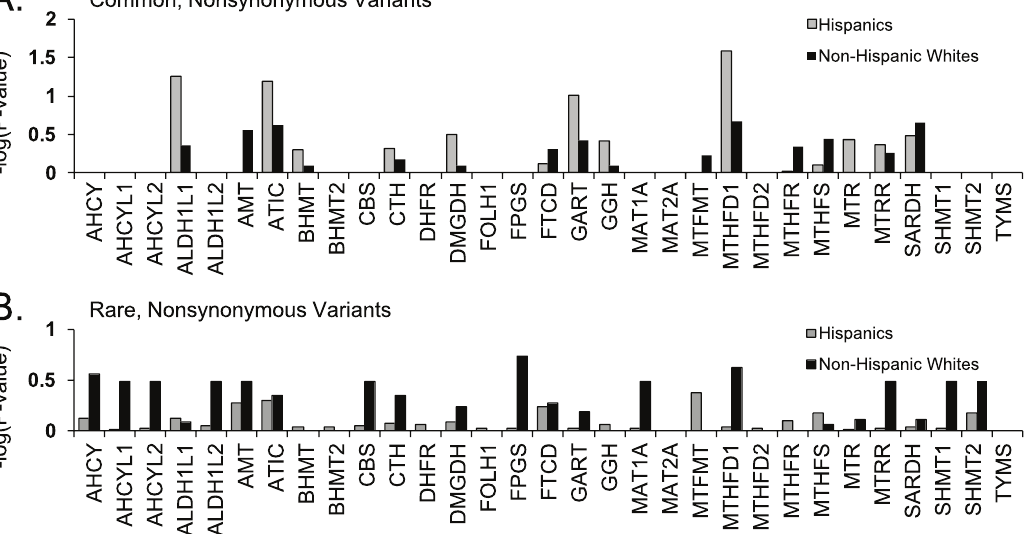
Figure 2. Allele Sums by Individual Gene. Common and rare nonsynonymous changes were summed as in Figure 1 except here on a gene-by- gene basis rather than considering the pathway as a whole. –log (P-values) were calculated by permutation (but not adjusted for multiple comparisons) based on the case/control distributions within each gene in Hispanics and non-Hispanic whites. On the y-axis, 1.3 corresponds to P-